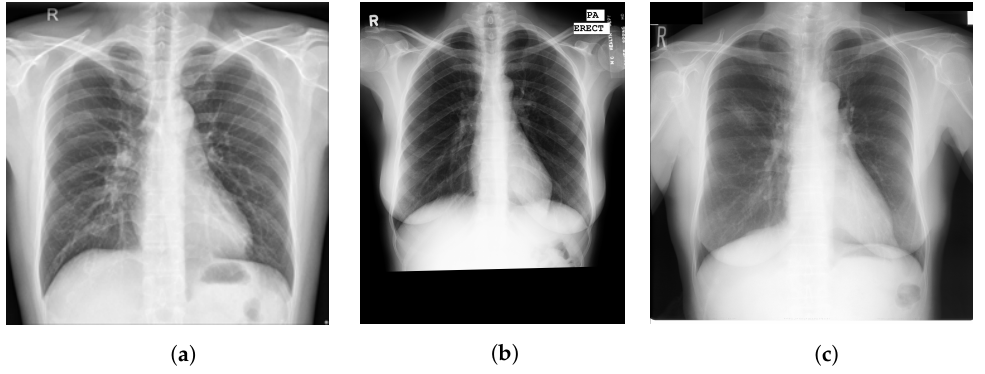
Figure 1. Example CRs from three databases: ( a ) radiograph from the Shenzhen database [34], ( b ) radiograph from the MC database [34], ( c ) radiograph from the JSRT database